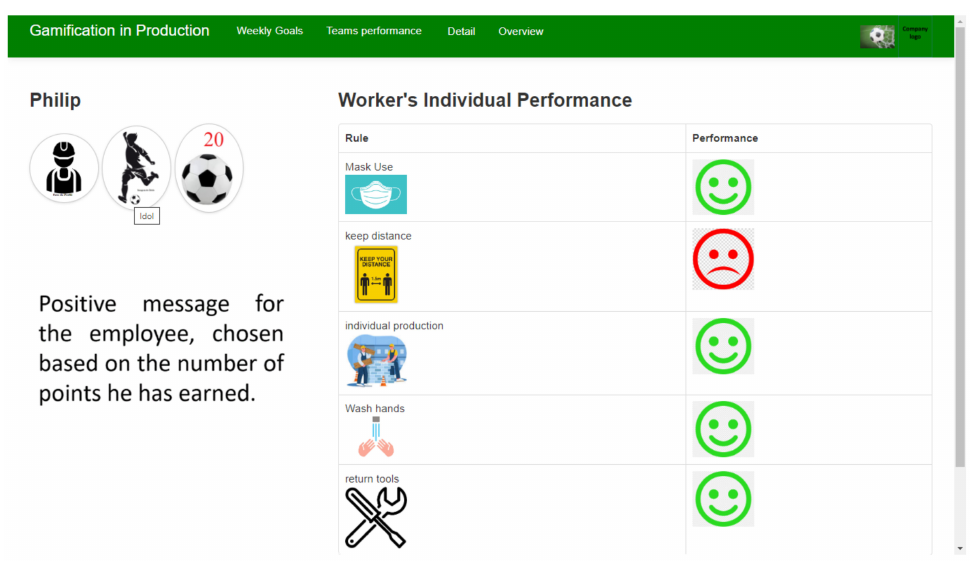
Figure 4. Worker performance through the private